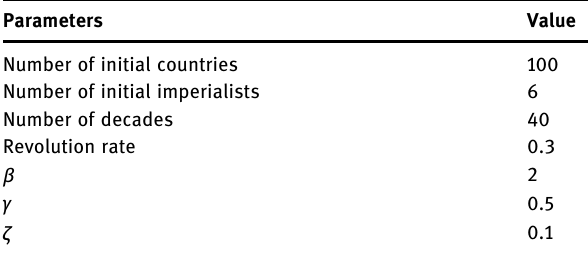
Table 6: Parameters of ICA for the optimization process Parameters